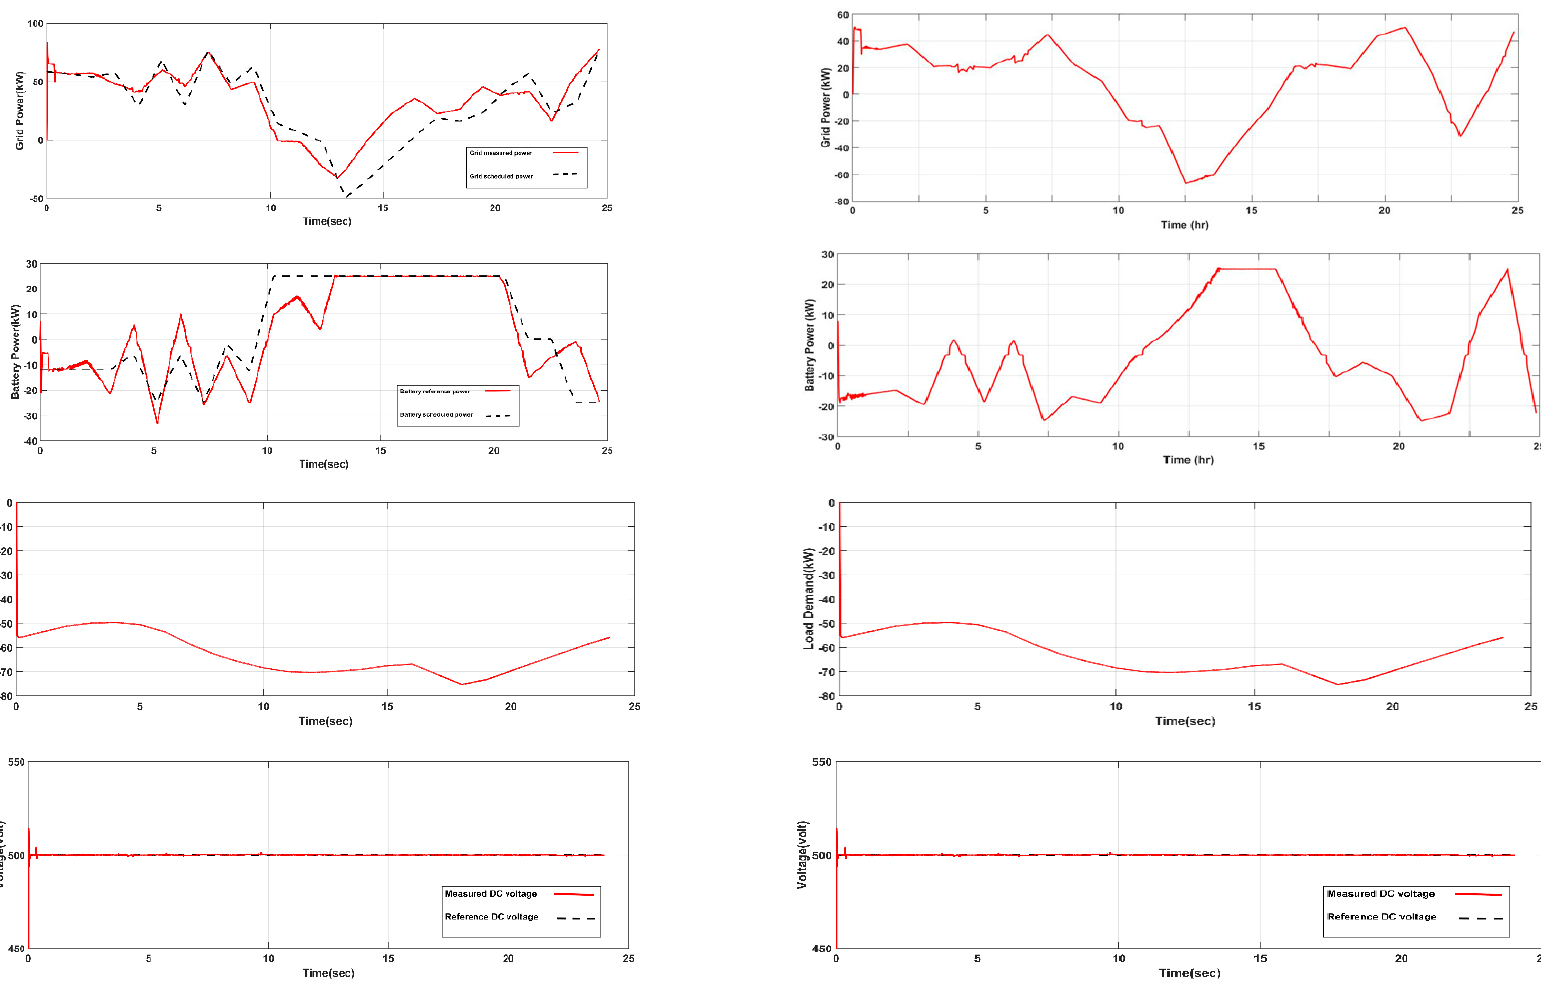
Figure 13. The output variables of the proposed MG with ( left side ) and without ( right side ) EMS in case 2.